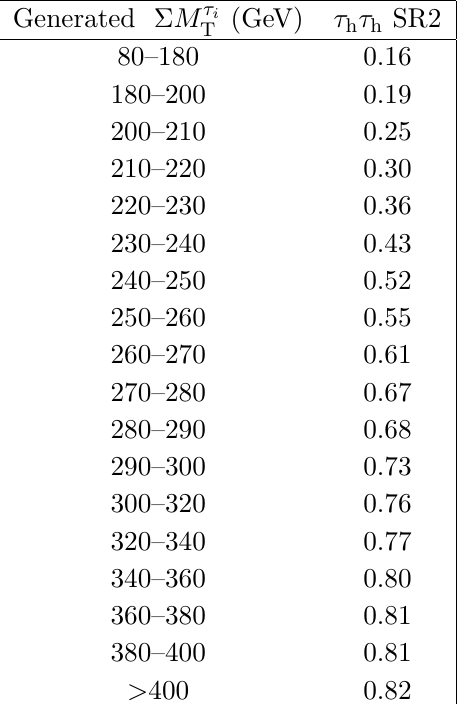
Table 14 . E(cid:14)ciencies of the (cid:6) M (cid:28) i